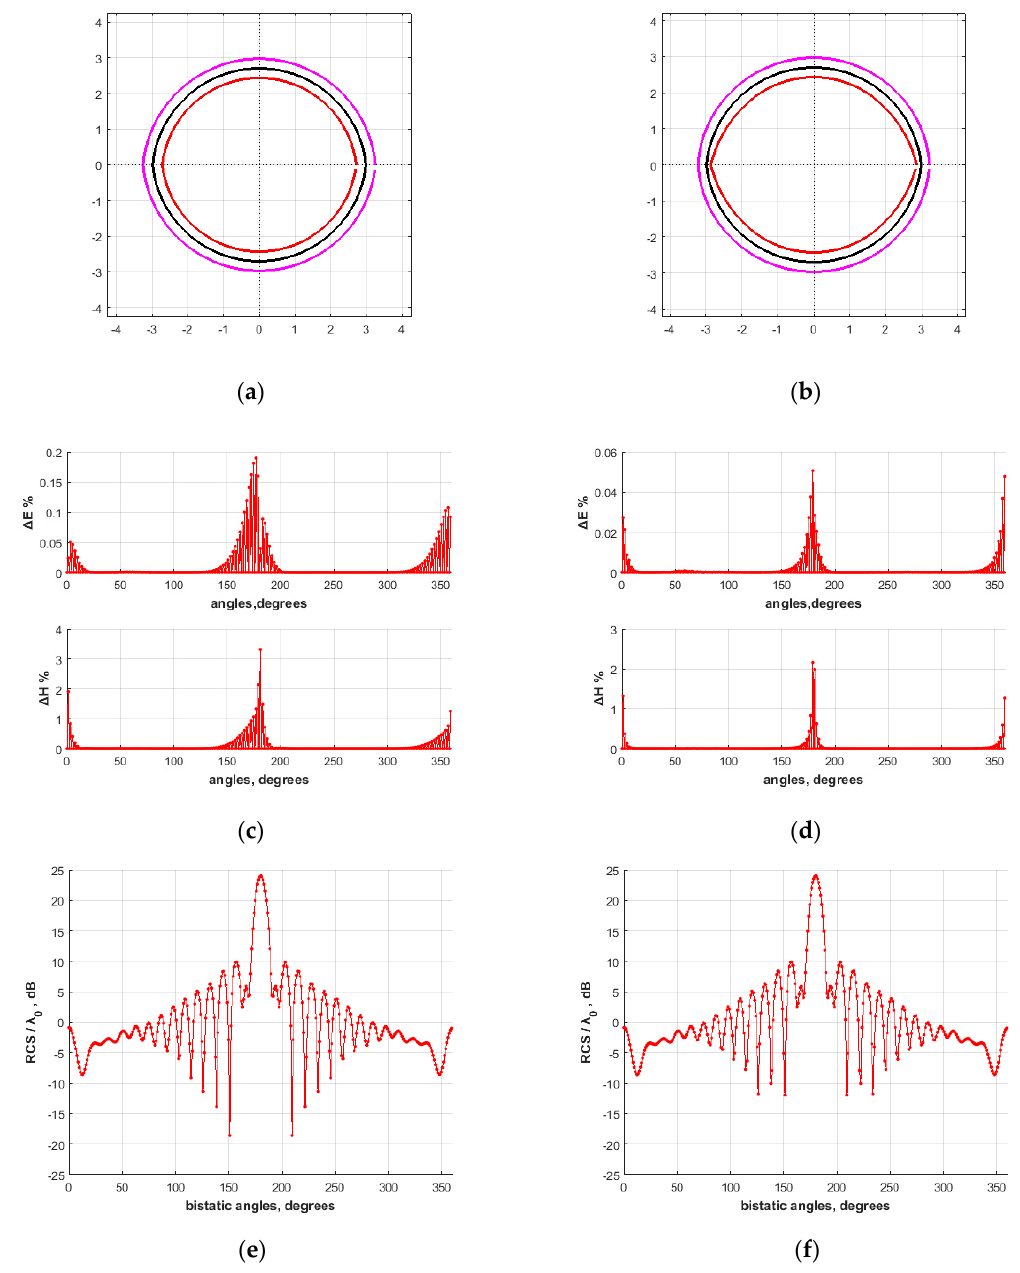
Figure 10. Small arc displacement d = 0.1 ρ = 0.3 λ : ( a ) geometry and conformal auxiliary surfaces; ( b ) geometry and improved auxiliary surfaces; ( c ) conformal ∆ E and ∆ H error; ( d ) improved ∆ E and ∆ H error; ( e ) conformal RCS; and ( f ) improved RCS.